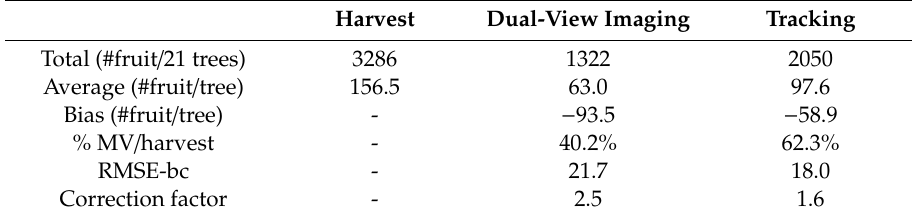
Table 2. Fruit count of each of 21 trees based on the harvest fruit tally, dual view imaging count (as per [32]), and tracking (MangoYOLO–Kalman filter–Hungarian algorithm) method count. Correction factors refers to the ratio of MV count to harvest tally.